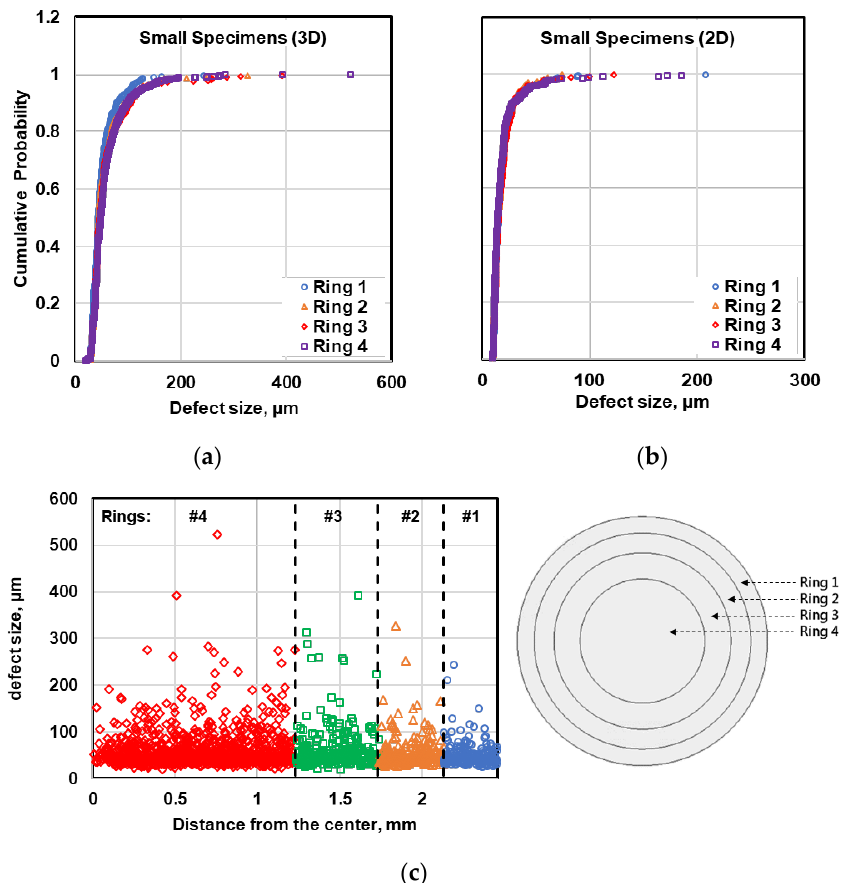
Figure 13. Comparison of the radial distribution of the defects within the cross section in small specimens using ( a ) µCT data, ( b ) metallography data, and ( c ) illustration of defect distribution in radial direction within small specimens.